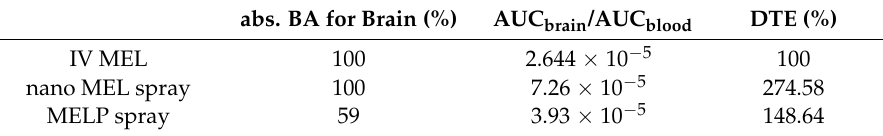
Table 2. Calculated parameters of spray forms apply IV administration as a